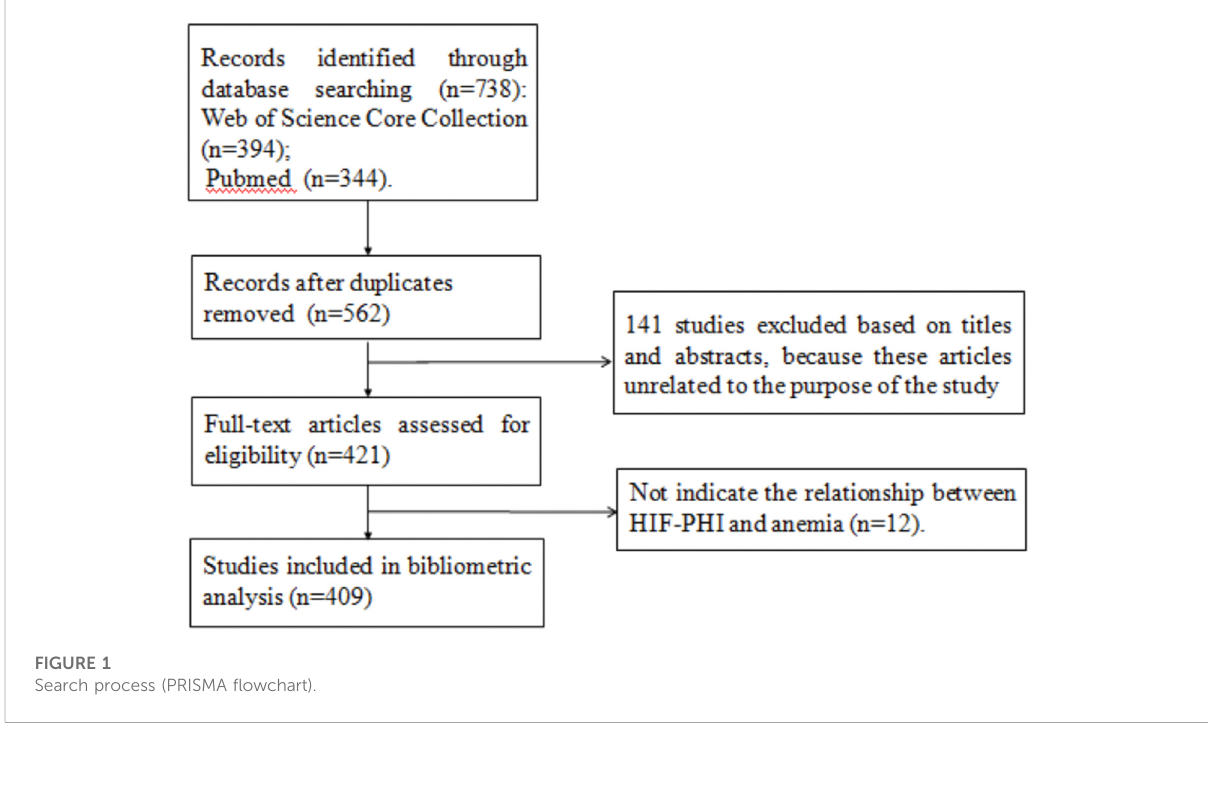
FIGURE 1 Search process (PRISMA fl owchart).